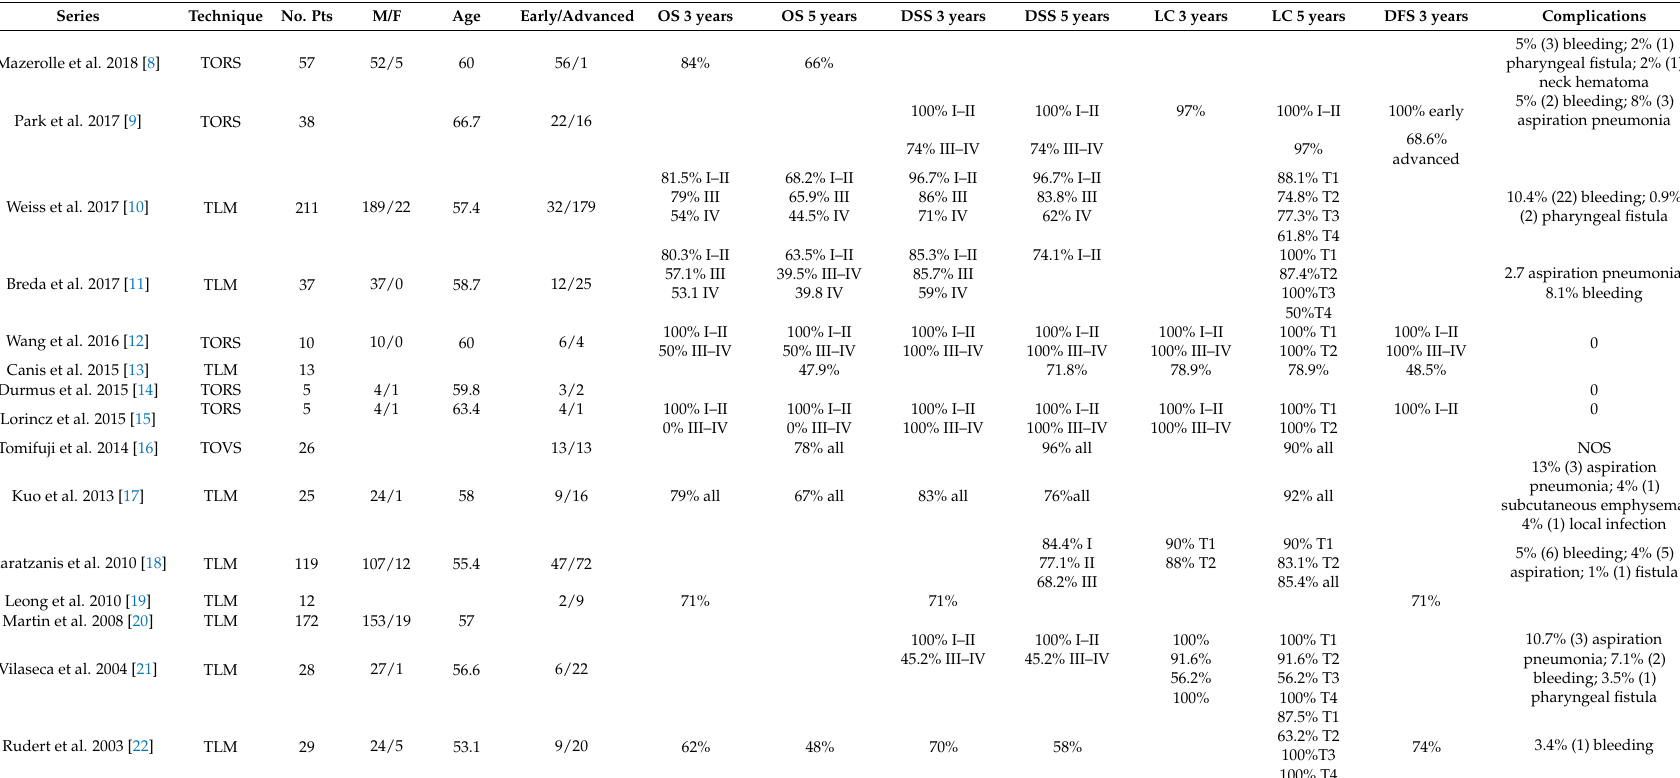
Table 1. Summary of demographics, survival, and complications of the included